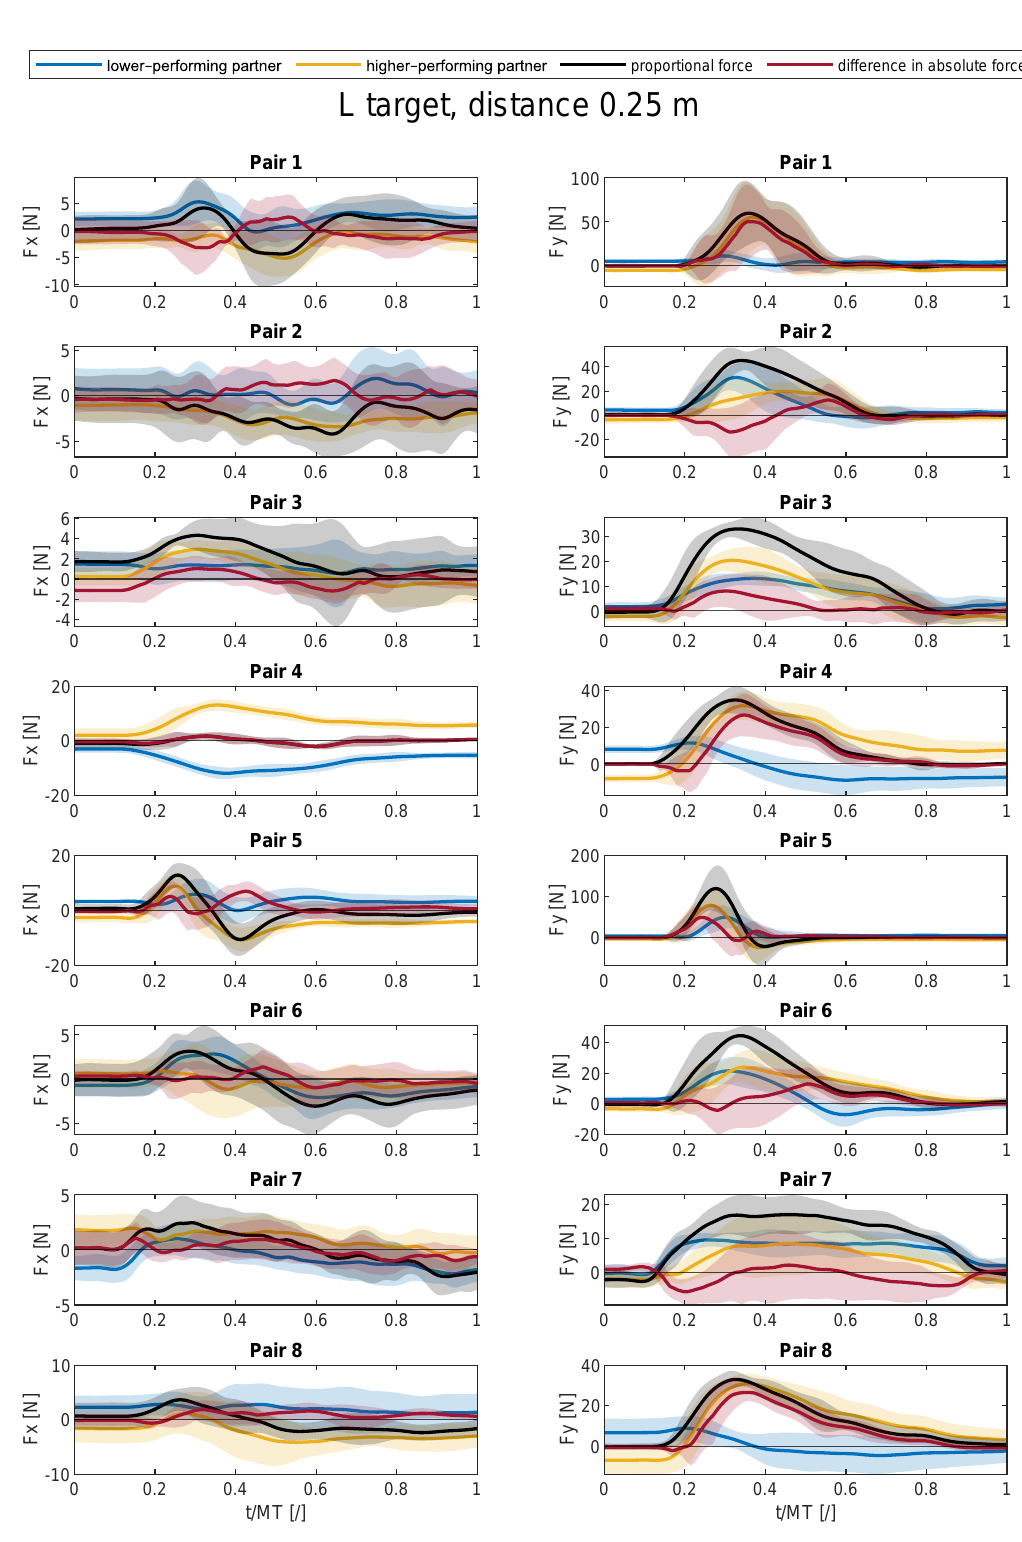
Figure A9. Average force trajectories with standard deviation (shaded area) in x- and y-direction in collaborative task for the large target at the distance of 0.25